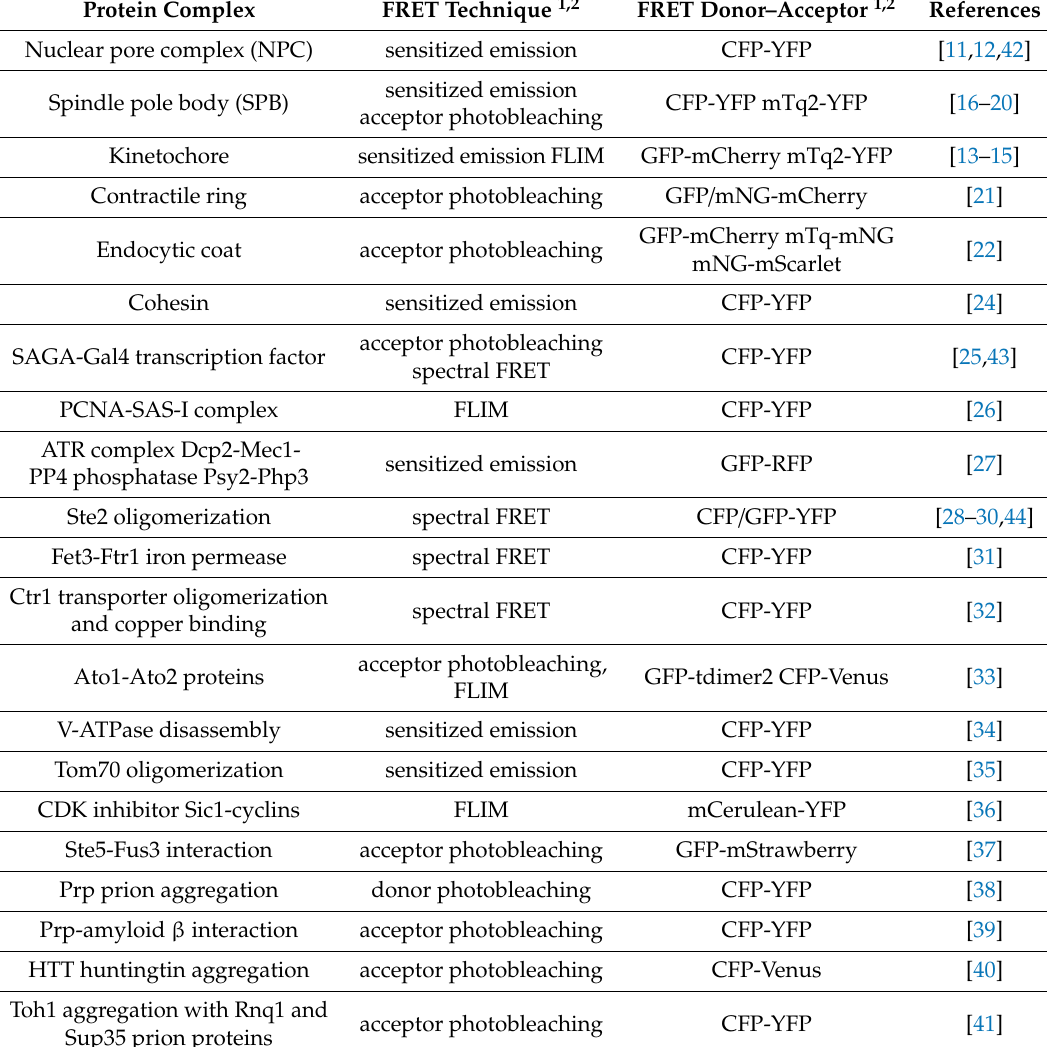
Table 1. Protein complexes analyzed by FRET in